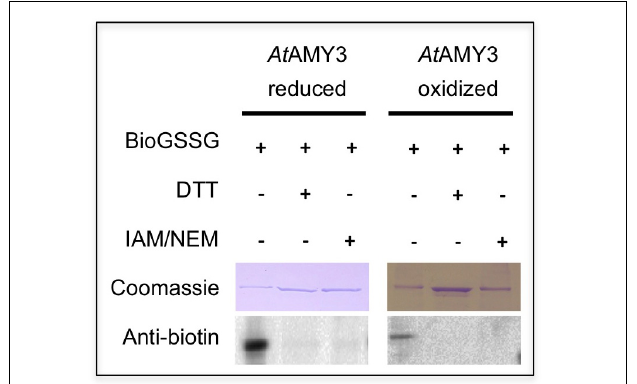
FIGURE 5 | p K a determination of the catalytic cysteines of At AMY3. At AMY3 was incubated in different buffers ranging from pH 4 to 12 in presence or absence of IAM before measuring the activity. The residual activity at each pH value was calculated as percentage of inhibition between IAM-treated and untreated samples, and expressed as a function of pH. The obtained curve was fitted by non-linear regression with two-p K a dependence. Results are mean ± SD ( n = 3; SD < 10% are omitted for